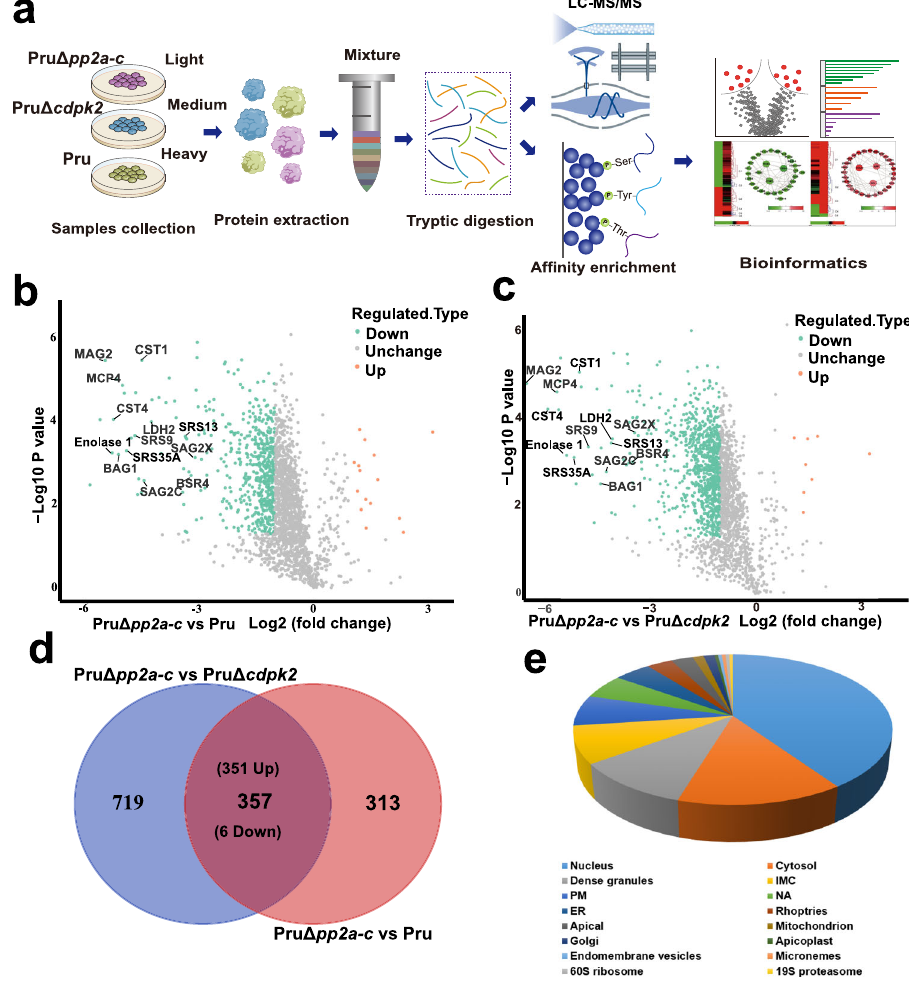
Fig. 6 | Comparative phosphoproteomic analysis of Pru Δ pp2a-c , Pru Δ cdpk2 strains, and their parental Pru strain under alkaline culture conditions. a Schematic representation of the work fl ow of comparative proteomic and phos- phoproteomic analyses. Parental Pru, Pru Δ cdpk2, and Pru Δ pp2a-c strains were grown in heavy, medium, or light SILAC labeling medium, respectively. After labeling, tachyzoites were allowed to differentiate to bradyzoites for 4 days under SILAC labeling medium, then the samples were harvested by needle passage, and proteinsweremixed 1:1:1beforetrypticdigestion.Phosphopeptideswereenriched